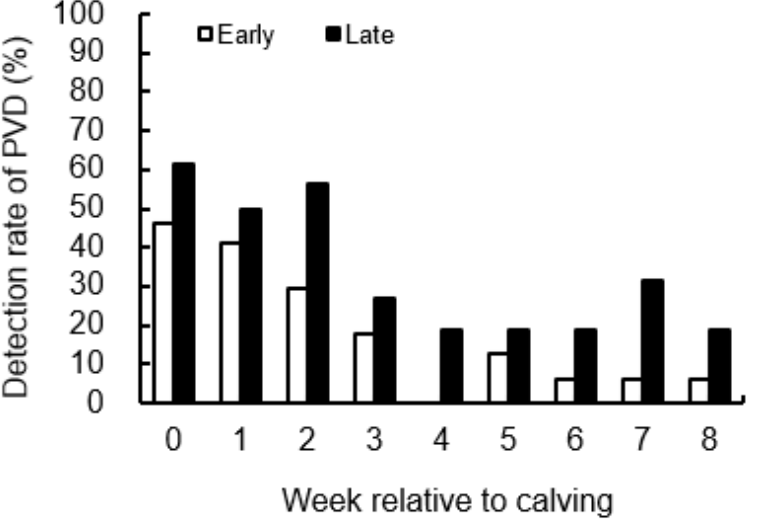
Figure 7. Detection rate of purulent vaginal discharge (PVD) from 0 to 8 wk relative to calving for